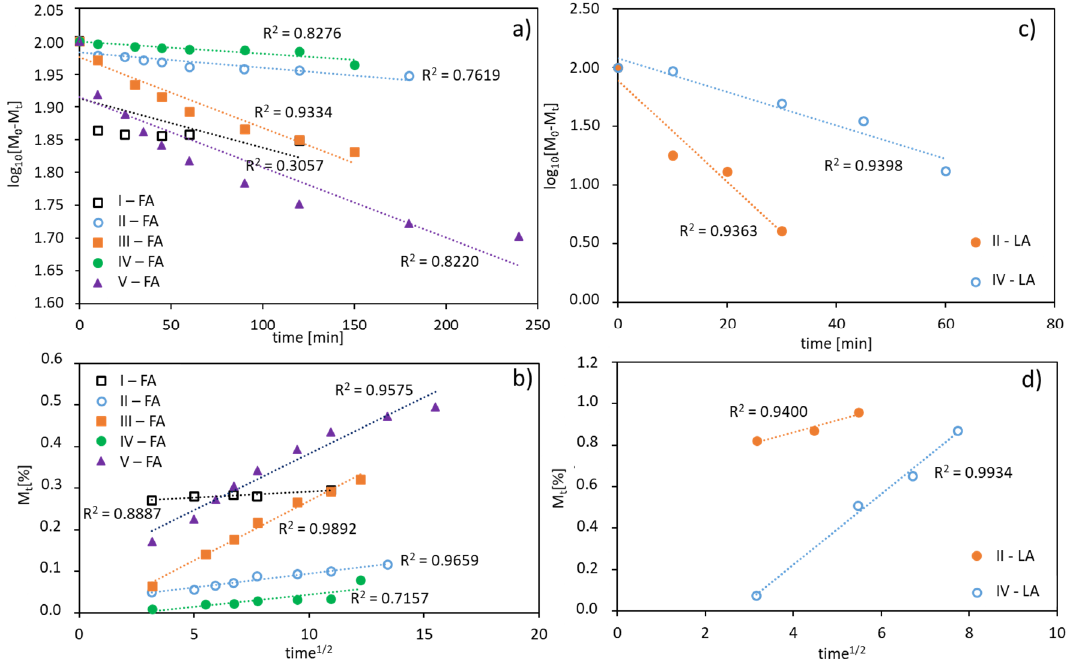
Figure 7. FA ( a , b ) and LA ( c , d ) release profiles from polymer conjugates fitted using a first-order equation ( a , c ), and a plot of the released drug vs. square root of time according to the Higuchi equation model ( b , d ).